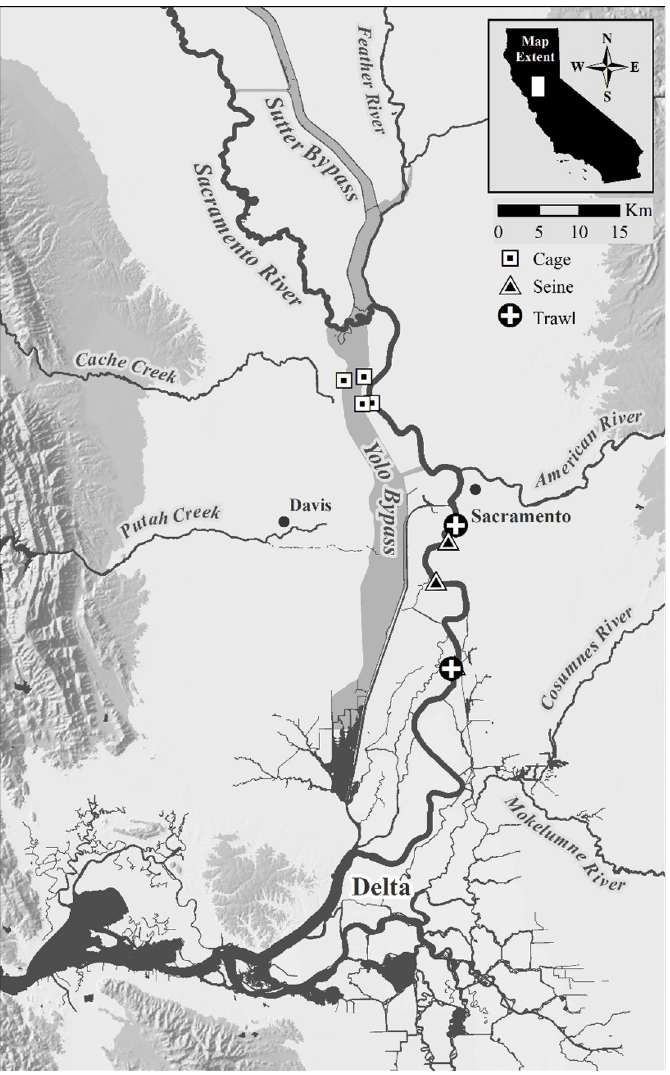
Fig 1. Map of the Sacramento River and upper San Francisco Estuary, showing the Yolo Bypass and sample locations.